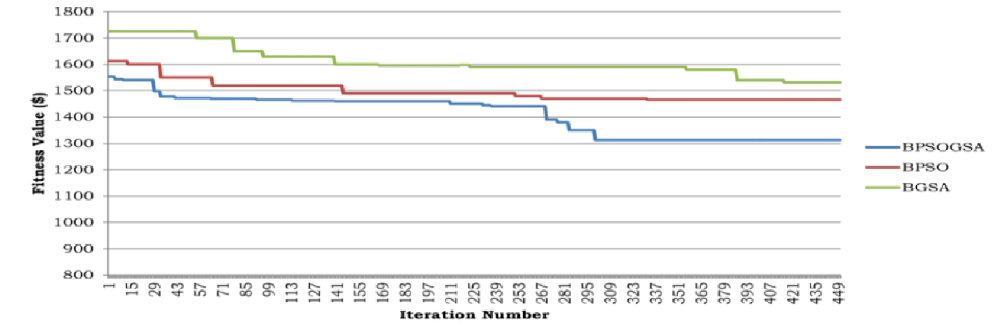
Figure 12. Convergence Curve of the hybrid